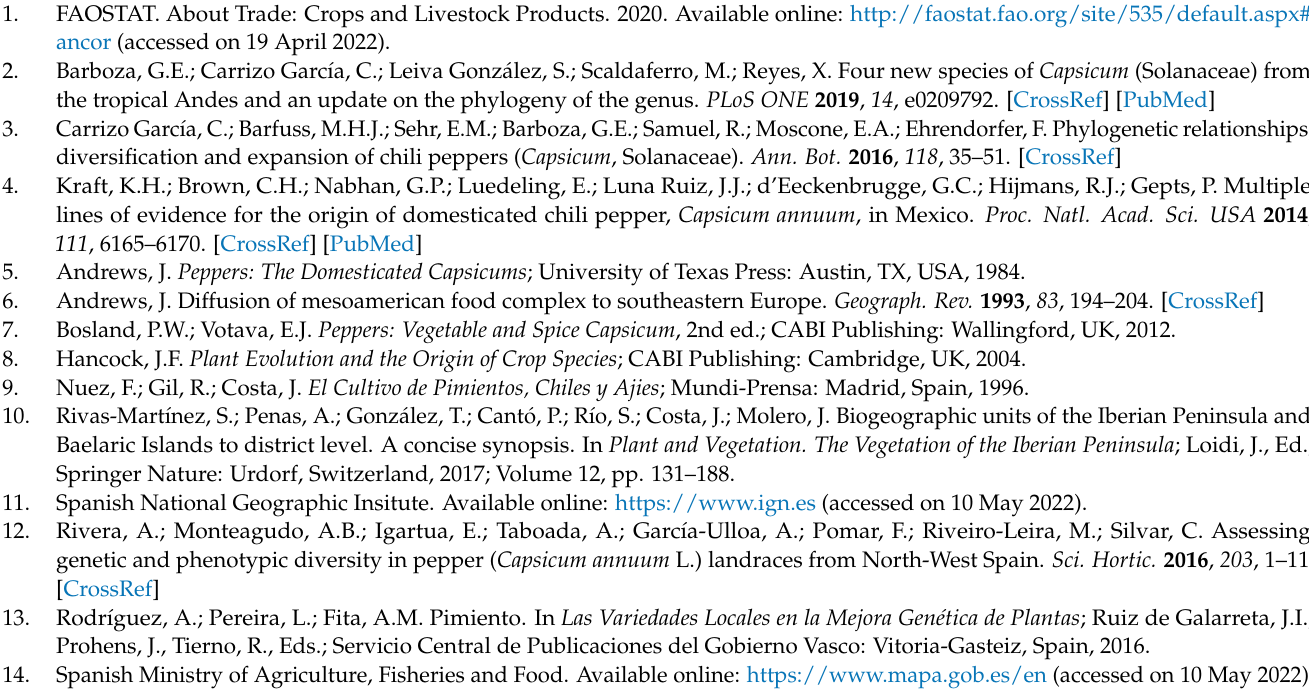
v 3 software; Figure S1. Pearson’s rank correlation coefficients between pairs of traits. Color intensity (right scale) and the size of circles are proportional to the correlation coefficients. Significant and non-significant correlations are shown; Figure S2. Contribution coefficients of each trait to the two principal components (PCs); Figure S3. Biogeographic provinces of the Iberian Peninsula. Modified from Rivas-Martinez et al.